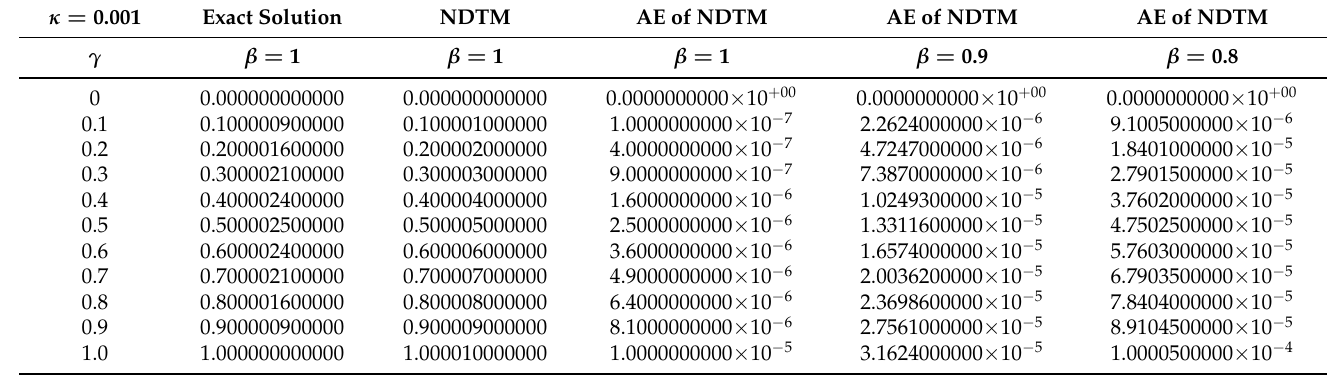
Table 1. Example 1 Exact solution, proposed technique solutions and AE for ρ ( ¯ ζ , ¯ (cid:61) ) .